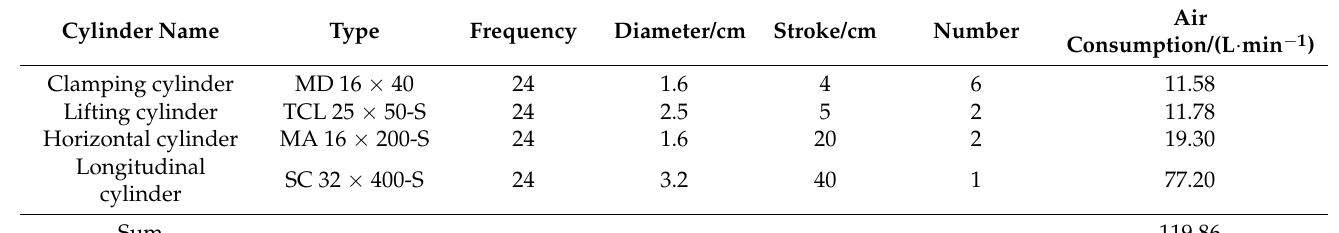
Table 2. Calculations result of air